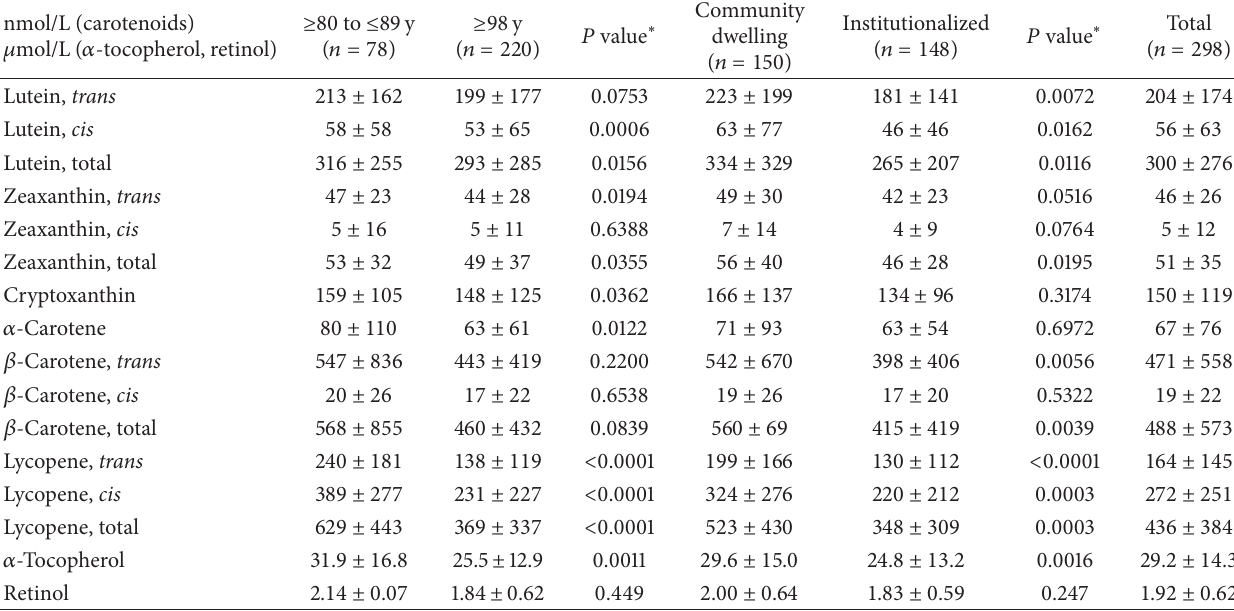
Table 2: Serum carotenoid, 𝛼 -tocopherol, and retinol concentrations in subjects from the Georgian Centenarian Study (mean ± SD). nmol/L (carotenoids) 𝜇 mol/L ( 𝛼 -tocopherol, retinol)